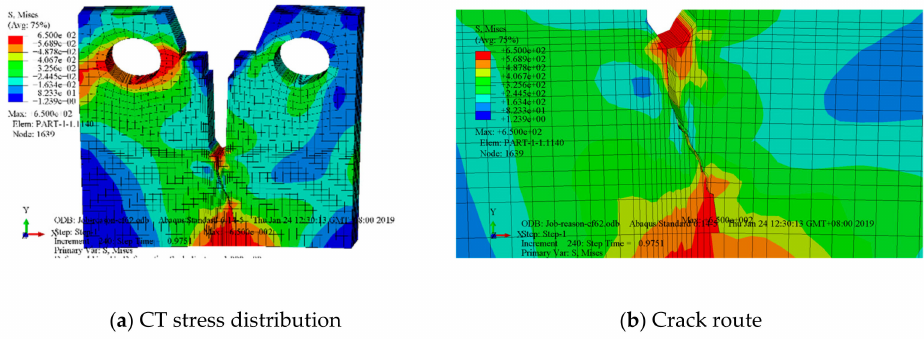
Figure 17. XFEM result of the parent material. ( a ) CT stress distribution; ( b ) Crack route.